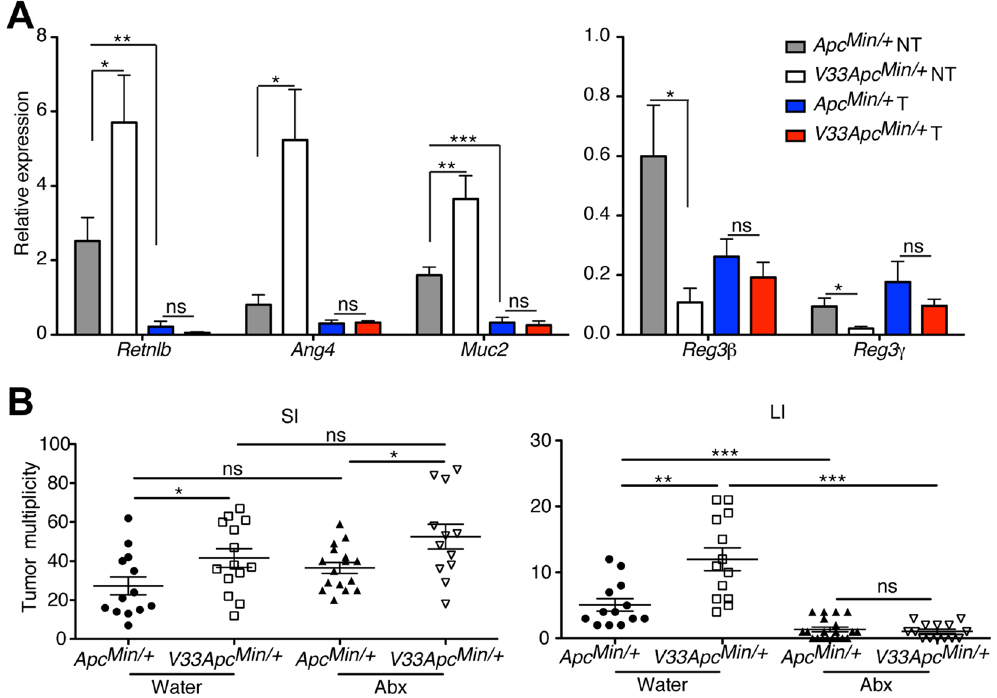
Figure 7. Epithelial-derived IL-33 alters antimicrobial genes expression in the colon. ( A ) Relative expression levels of Reg3b , Reg3g , Ang4 , Retnlb and Muc2 were analyzed by qPCR in the colon of size-matched tumor area (T) and adjacent non-tumor normal area (NT) of Apc Min/ + mice and V33 Apc Min/ + mice at d120. Data were normalized to the expression levels of the Ubiquitin transcript. Graphs show means ± s.e.m. n = 4–5/group. * P < 0.05, ** P < 0.01, *** P < 0.001, one-way ANOVA. ( B ) Number of polyps in the intestine of Apc Min/ + mice and V33 Apc Min/ + mice receiving water or antibiotic continuously from weaning to 120 days post-birth. Graphs show means ± s.e.m. * P < 0.05, ** P < 0.01, *** P < 0.001, nonparametric Mann-Whitney